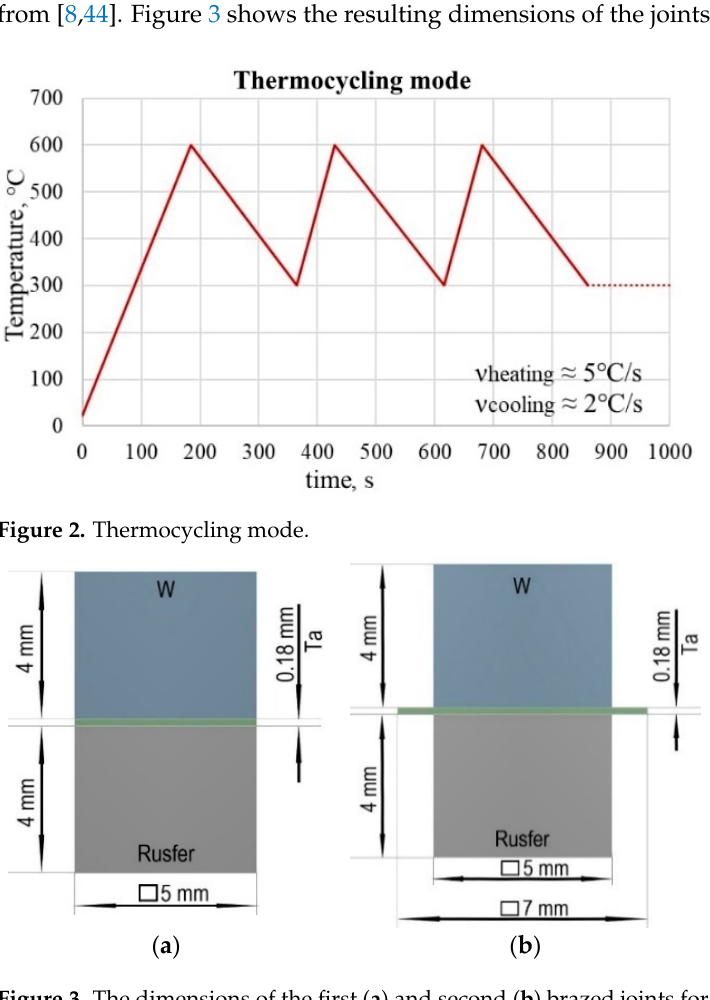
Figure 3. The dimensions of the first ( a ) and second ( b ) brazed joints for thermocycling tests. Figure 4 shows the generated mesh. The element size in the tantalum layer and near both contact regions is 0.01 mm. The element size in the tungsten and Rusfer layers is 0.05 mm.